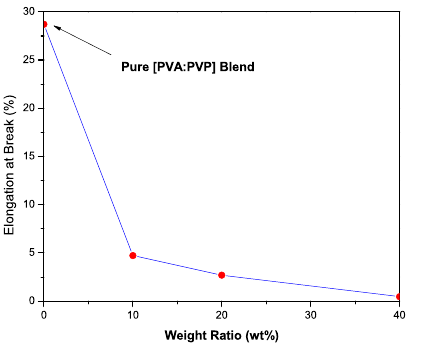
Figure 8: Young’s modulus of pure and PVA:PVP poly- mer blend films reinforced with different weight ratios of CdCl 2 · H 2 O salt.